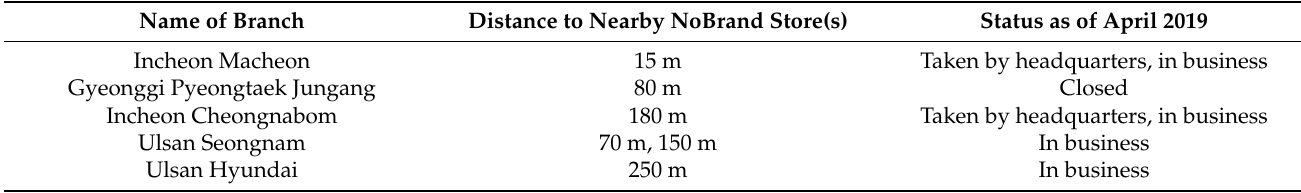
Table 3. Legal Disputes between Emart24 and Emart Regarding NoBrand. Name of